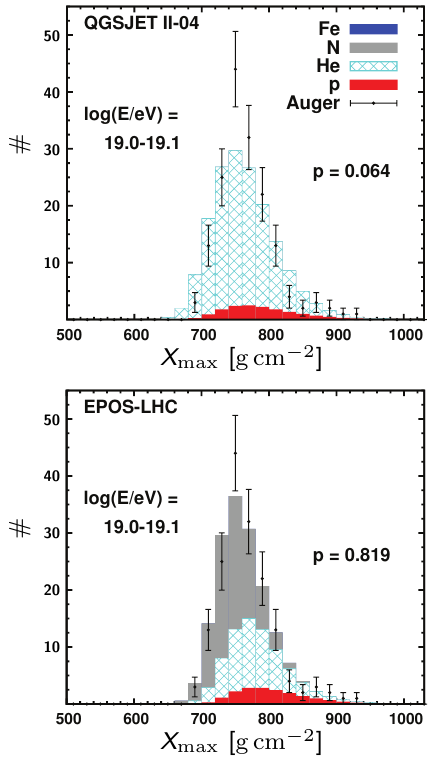
Figure 5. AugerMix for QGSJetII-04 (top) and EPOS-LHC (bot- tom) for 10 19 . 0 eV < E < 10 19 . 1 eV [8]. The agreement with the data is indicated using p